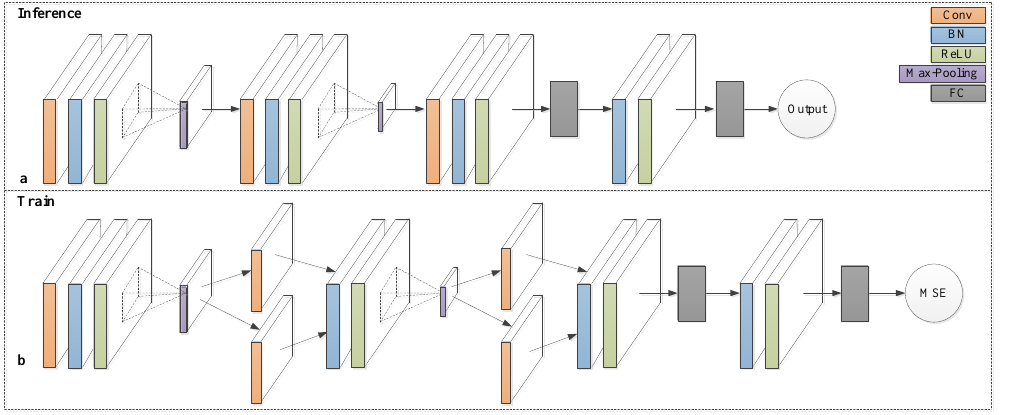
Figure 3. Training and inference structures of the proposed SNR network in this paper. ( a ) The structure of the inference network; ( b ) The structure of the training network.